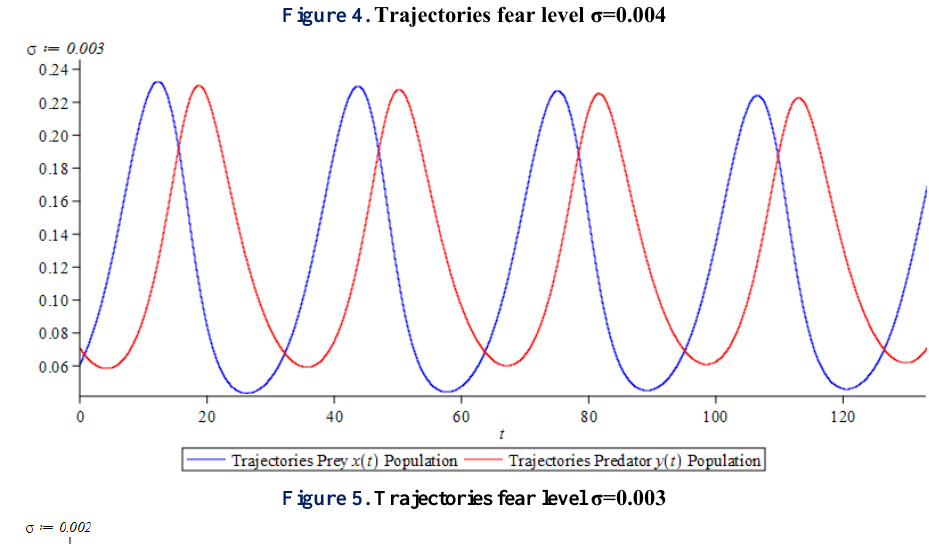
Figure 4. Trajectories fear level σ=0.004